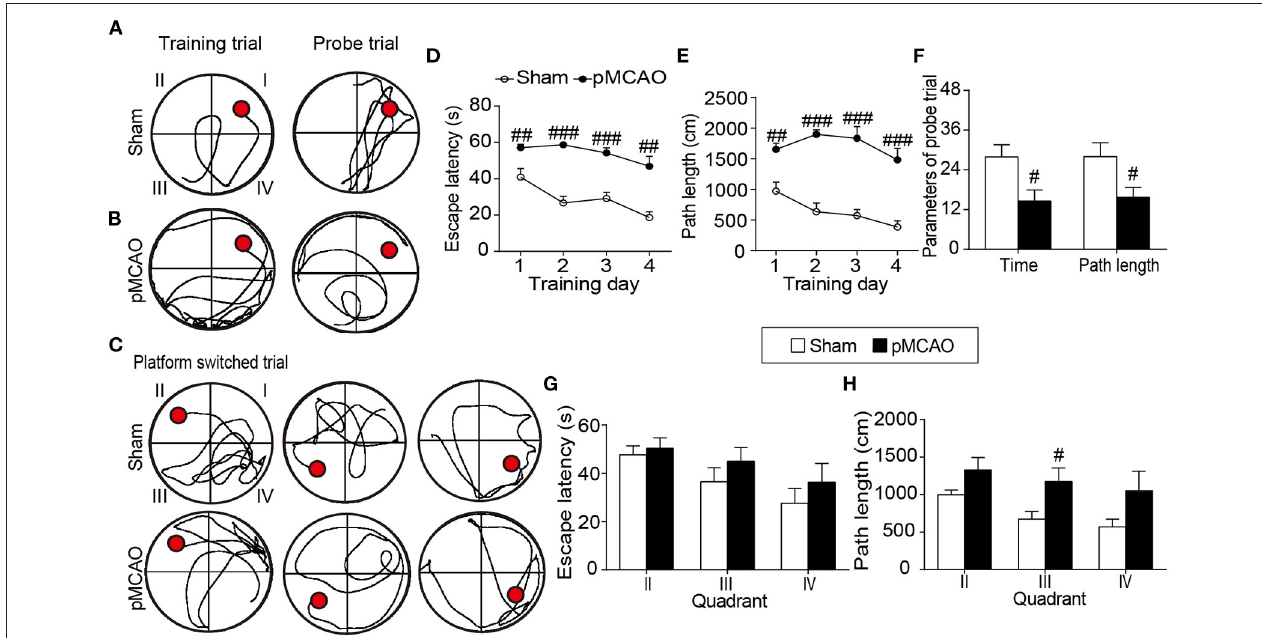
FIGURE 2 | pMCAO caused cognitive decline in rats. (A–C) Representative swimming traces of the sham and pMCAO rats in the training trial, probe trial, and platform switched trial, respectively. (D,E) Quantitative data of the escape latency and path length of rats spent to locate the submerged platform during the training trial. (F) Quantitative analysis of the percentage time and path length of rats spent in the original quadrant in the probe trial. (G,H) Quantitative analysis of the escape latency and path length of rats taken to find the switched platform during the platform switched trial (Two-way repeated measures ANOVA with between subject factor-surgery and within subject factor-time for (D) and (E) . Student’s t -test for (F–H) . N = 8 for the sham group and N = 9 for the pMCAO group). # P < 0.05, ## P < 0.01, ### P < 0.001 vs. sham